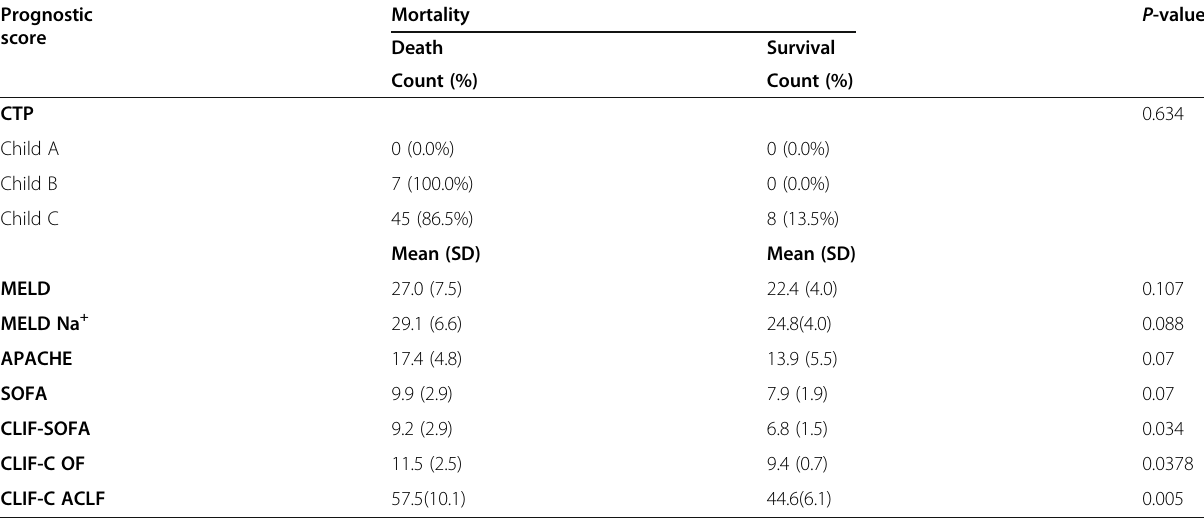
Table 6 Prognostic scores on admission and mortality Prognostic score